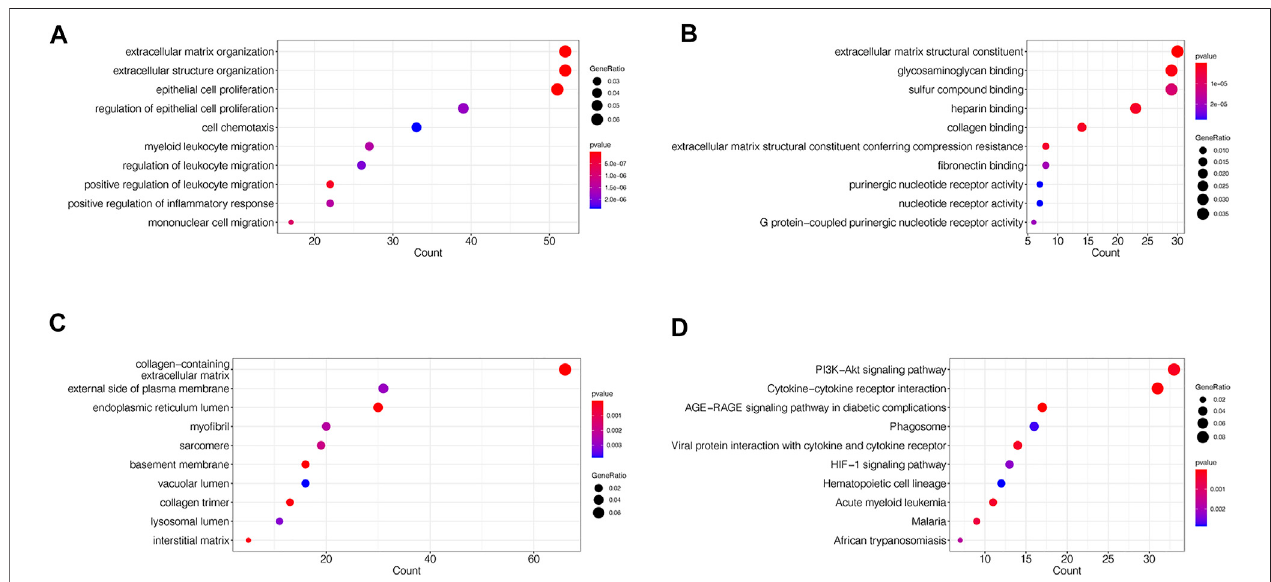
FIGURE 3 | GO and KEGG enrichment analyses of DEGs in merged dataset (A) The dot plots of the top 10 enriched GO BP terms (B) The dot plots of the top 10 enriched GO MF terms (C) The dot plots of the top 10 enriched GO CC terms (D) The dot plots of the top 10 enriched KEGG